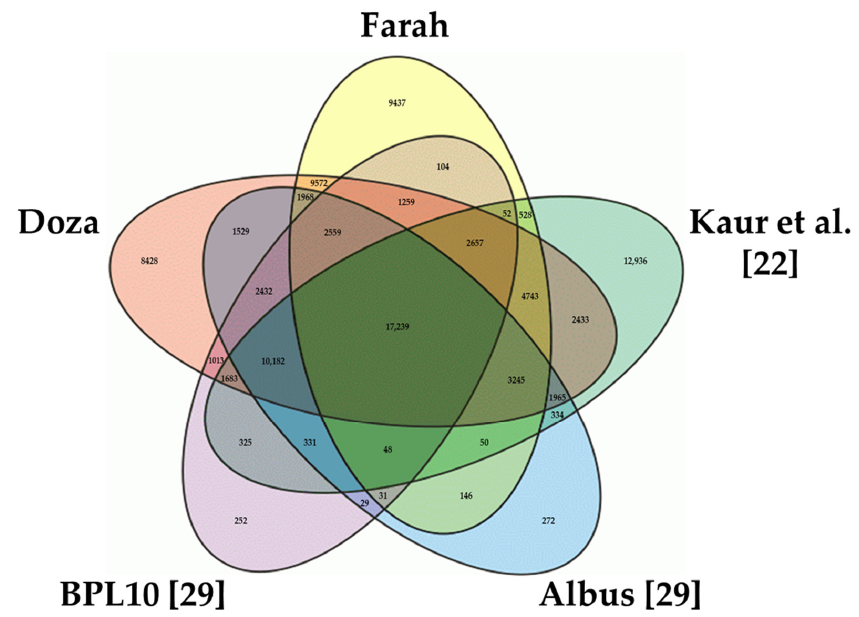
Figure 2. Venn diagram depicting the distribution of BLAST matches between Farah-specific and Doza-specific reference transcripts with sequences from Albus [29], BPL10 [29], and Kaur et al. [22] transcriptome